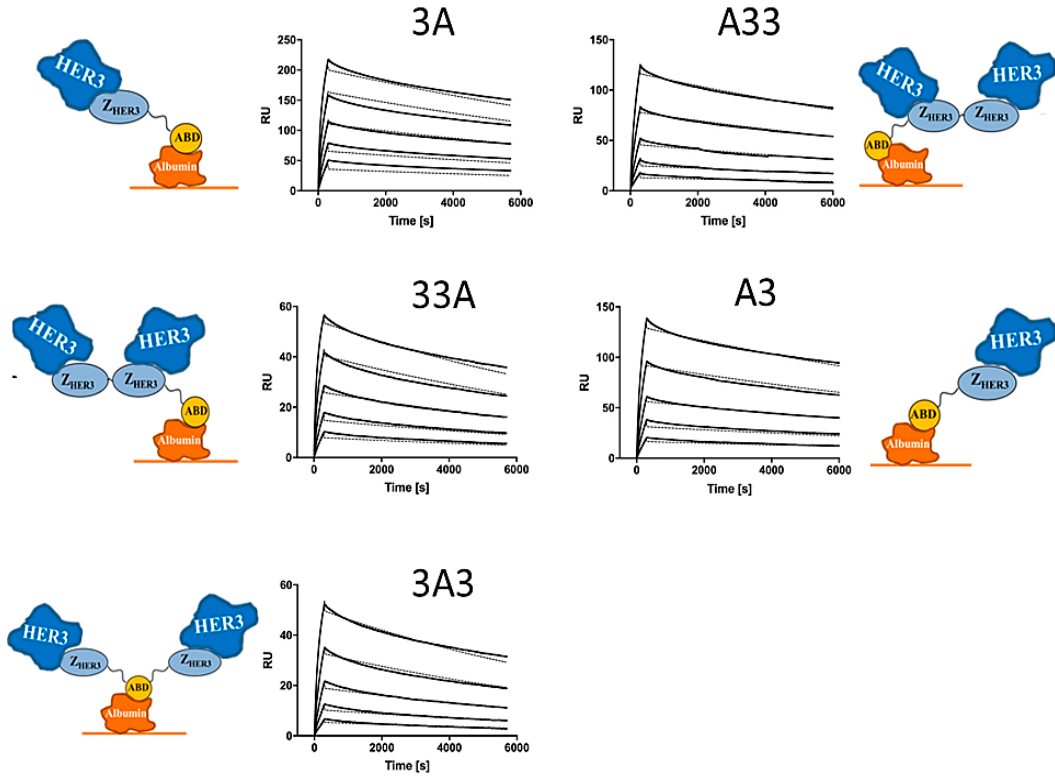
Figure 2. Representative experimental sensorgrams (solid) with fitted curves (dashed) from surface plasmon resonance (SPR) analysis for different ABD-fused anti-HER3 affibody constructs conjugated with a 1,4,7,10-tetraazacyclododecane-1,4,7,10-tetraacetic acid (DOTA) chelator at the C-terminus. Constructs were captured on immobilized HSA and subsequently subjected to five concentrations of human HER3 (3.125, 6.25, 12.5, 25, and 50 nM). Monovalent affinities to HER3, based on a Langmuir 1:1 model, are presented in Table 1.